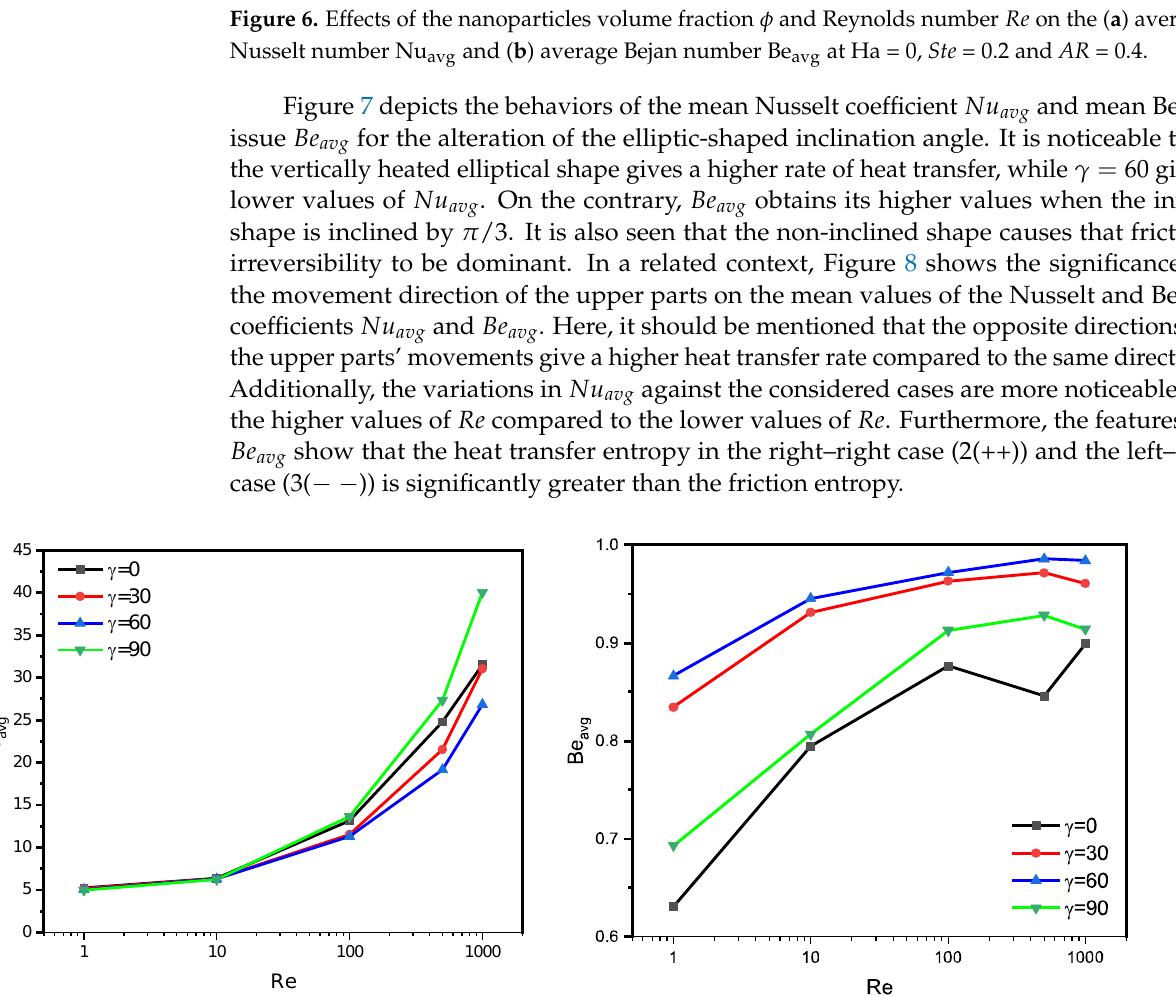
Figure 6. Effects of the nanoparticles volume fraction 𝜙 and Reynolds number 𝑅𝑒 on the ( a ) av- erage Nusselt number Nu avg and ( b ) average Bejan number Be avg at Ha = 0, 𝑆𝑡𝑒 = 0.2 and 𝐴𝑅 = 0.4.